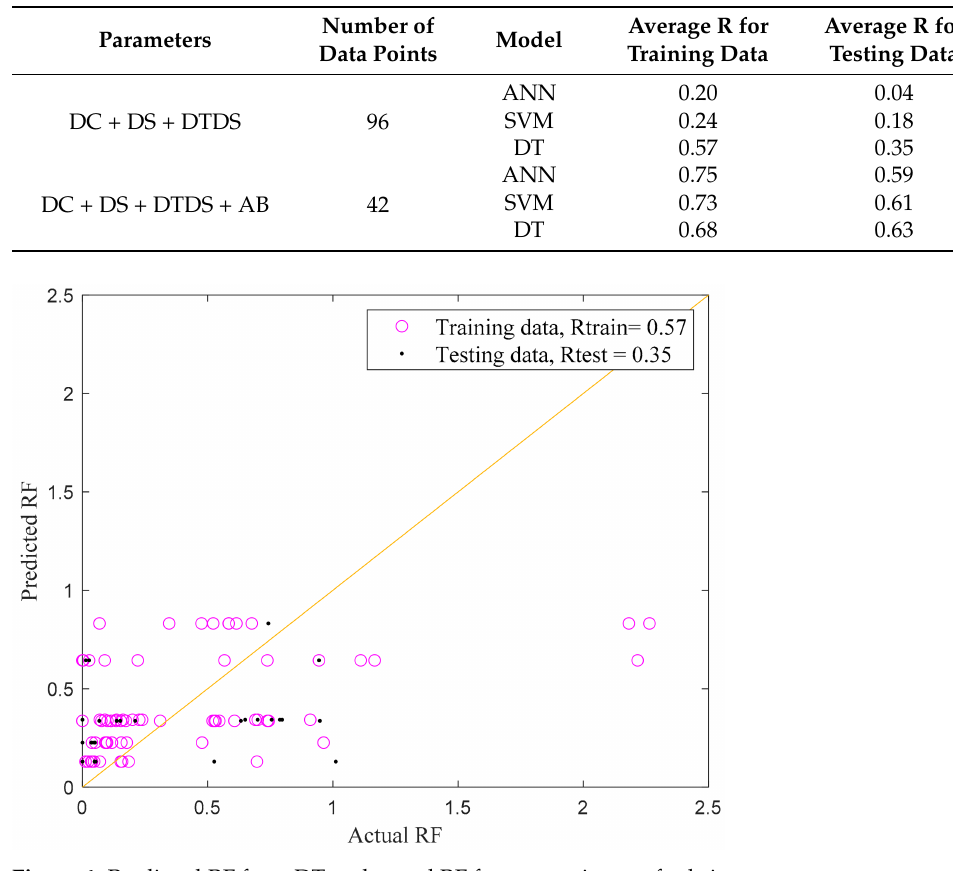
Figure 4. Predicted RF from DT and actual RF from experiments for brine parameters.